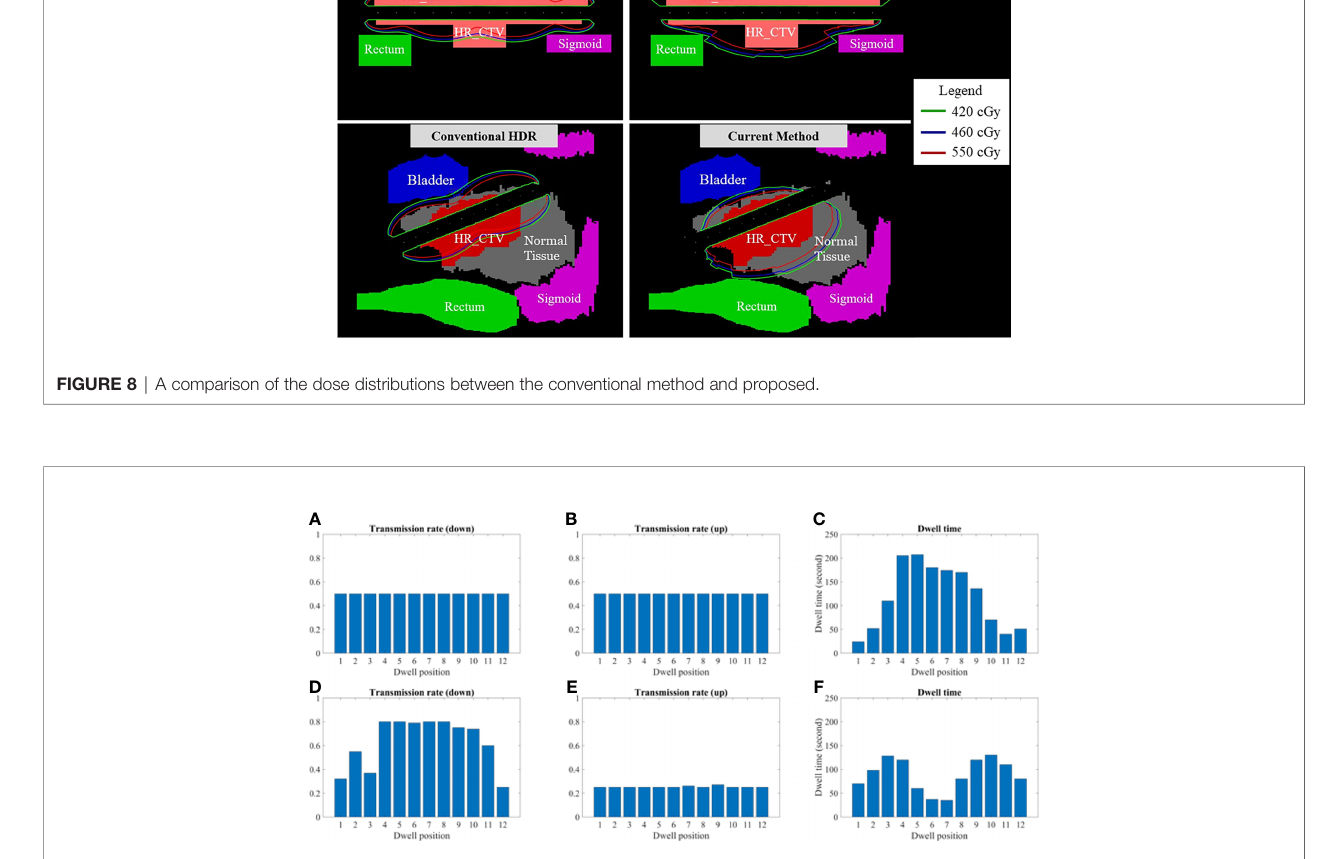
FIGURE 9 | A comparison between the conventional method and proposed using the 2D phantom model. (A – C) A transmission and dwell time for the conventional method. (D – F) A transmission and dwell time for the proposed method. To compare the proposed method with the conventional one, we use the same model and solver, but we fi x the transmission rates as constant (=